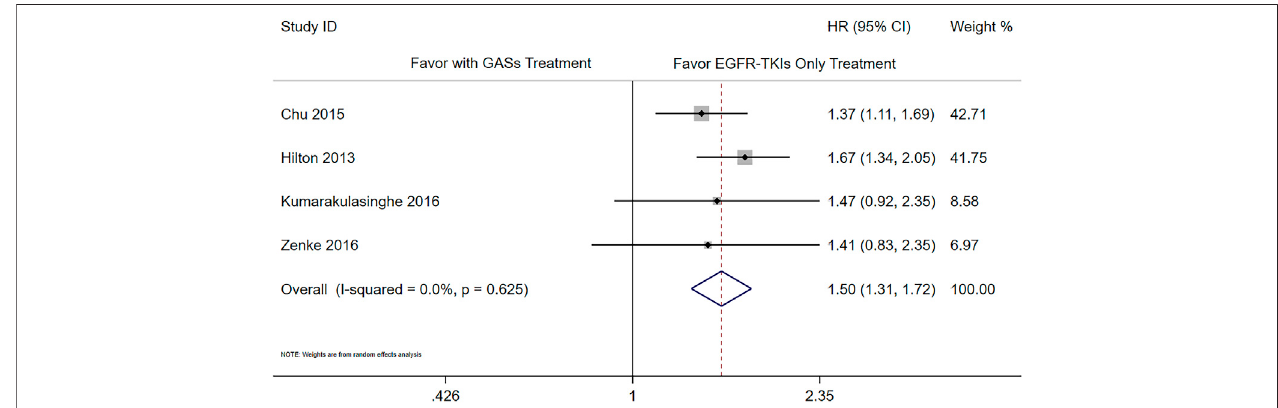
FIGURE 3 | In fl uence of the concomitant use of GASs on the